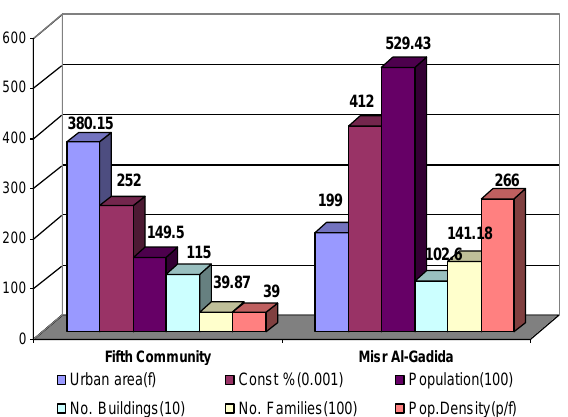
Figure 4. Site statistics comparison between the Fifth community and Misr Al-Gadida, the urban area is in Feddans (Feddan = 4200 m 2 ).